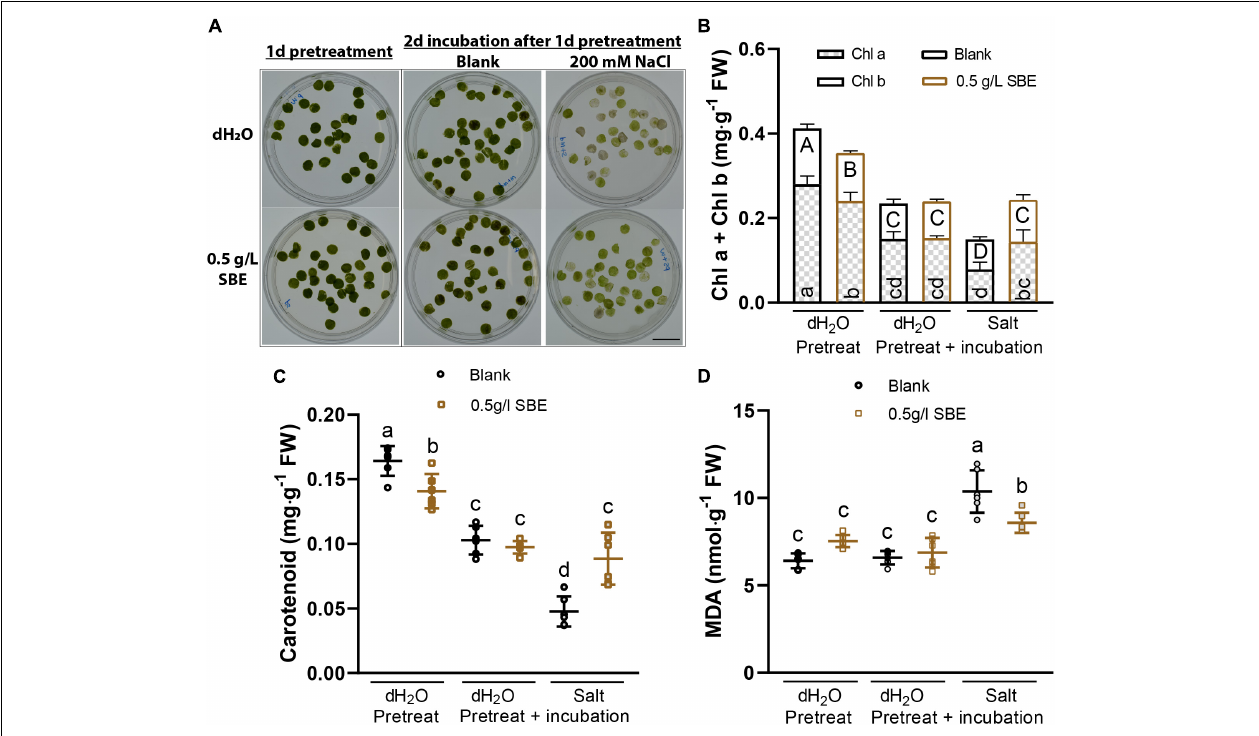
FIGURE 6 | Salt stress alleviation of SBE pretreatment on expanded Arabidopsis leaves in the leaf disc assay. (A) The representative image of treated leaf discs was taken before sampling. Bar = 2 cm. Photosynthetic pigments contain (B) chlorophyll a and b , and (C) carotenoid content. (D) MDA content. Error bars indicate SDs of the means ( n = 6). Different letters represent significant differences between treatments using Tukey’s HSD test ( p < 0.05). SBE, sunflower bark extract; DAG, days after germination; FW, fresh weight; Chl a, chlorophyll a; Chl b, chlorophyll b; MDA,